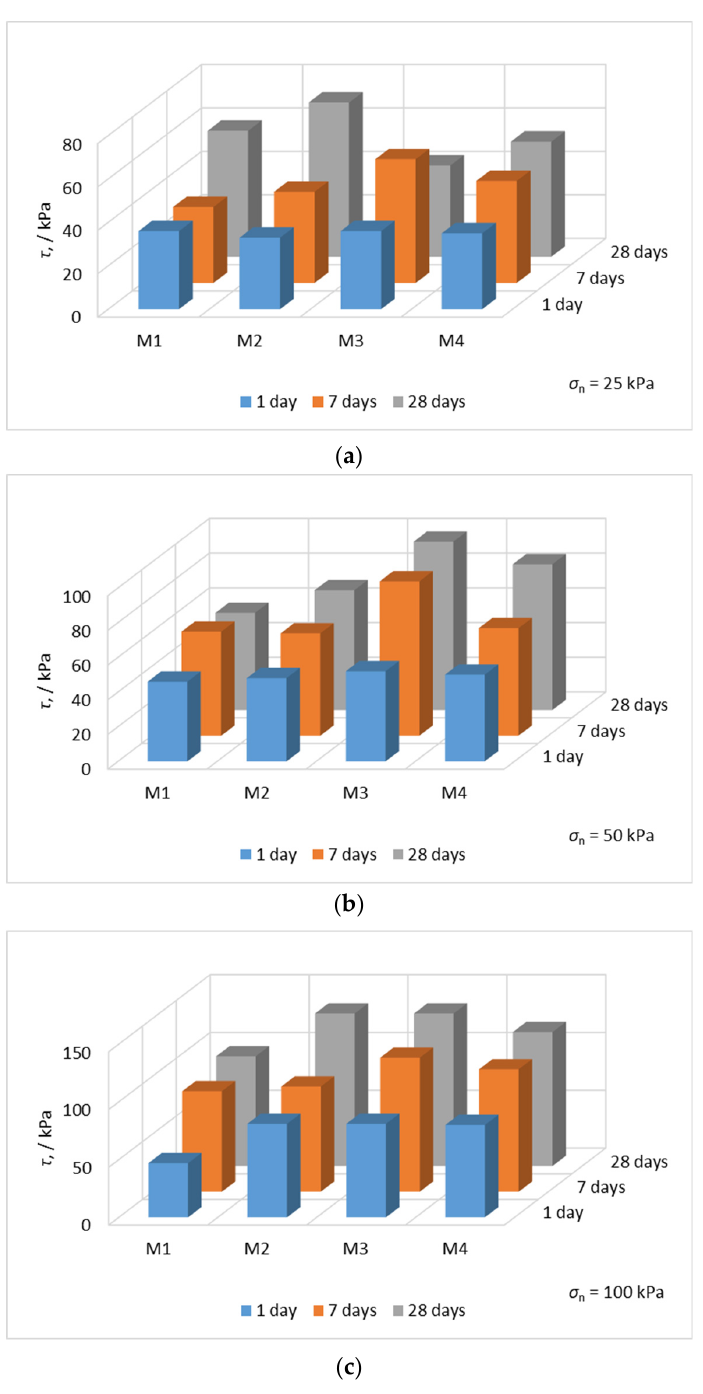
Figure 8. Comparison of peak shear stress values of samples M1–M4 (influence of soil composition) for samples aged 1 day, 7 days and 28 days: ( a ) σ n = 25 kPa; ( b ) σ n = 50 kPa; ( c ) σ n = 100 kPa.